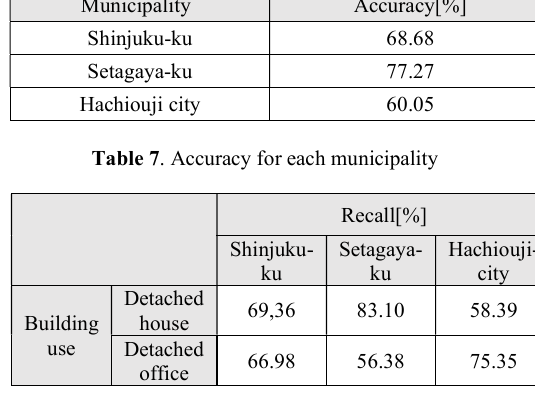
Figure 10 . Example of building images estimated as non- detached buildings